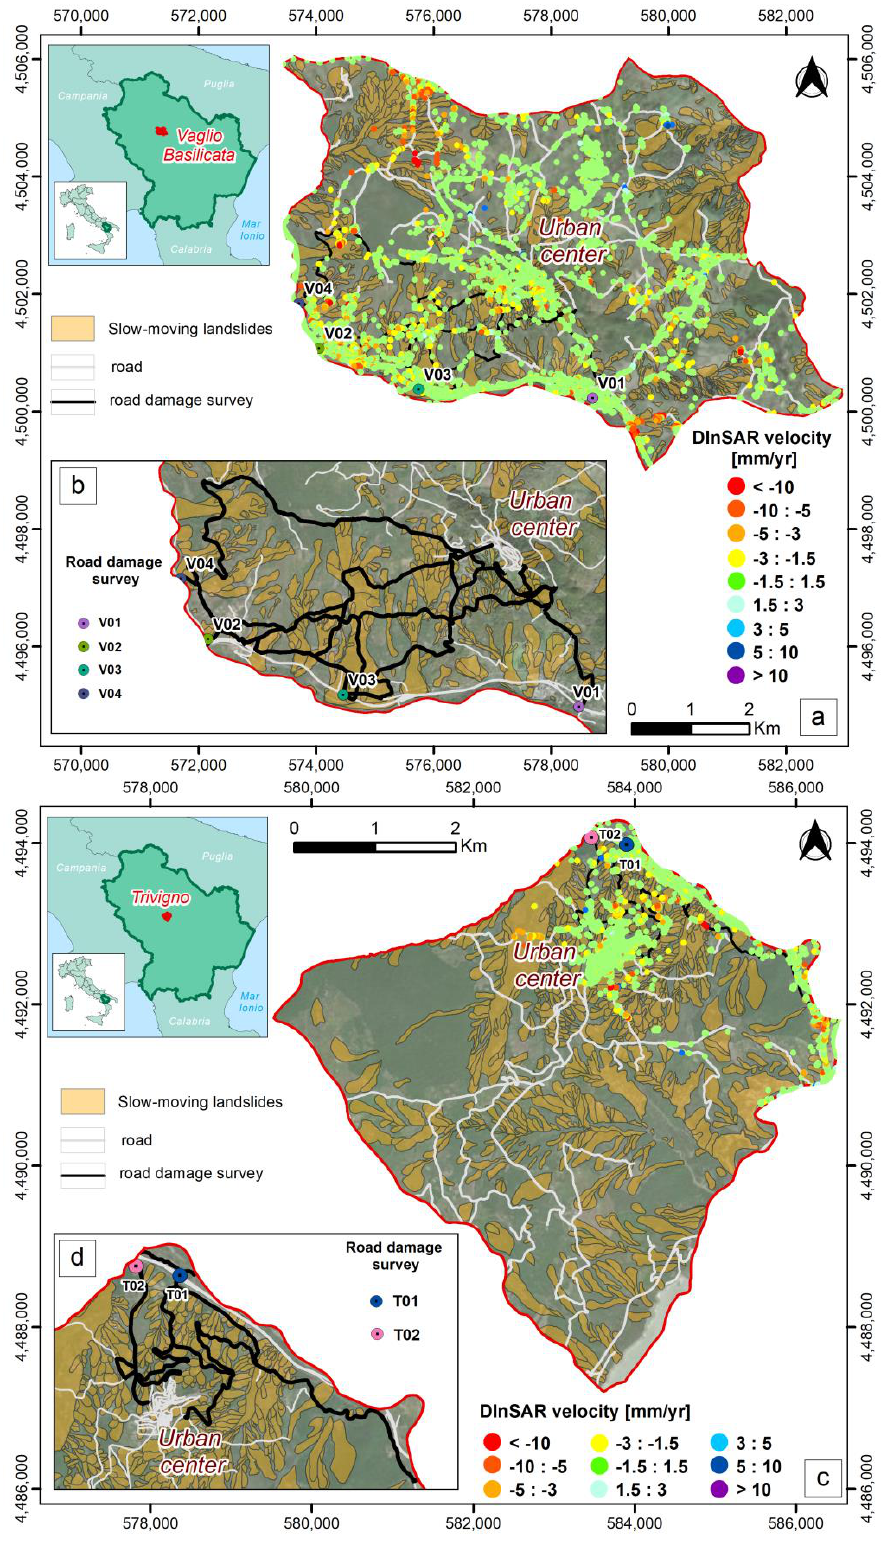
Figure 2. Aerial photos of Vaglio Basilicata ( a , c ) and Trivigno ( b , d ). ( a , c ) show the slow-moving landslides inventoried by the Interregional River Basin Authority of Basilicata and the spatial distribution of DInSAR velocities (road sections surveyed are marked in black) within the two municipalities. ( b , d ) focus on the main road stretches connecting highway SS407 Basentana to the two city centers. The insets show the location of the two municipalities within the Basilicata